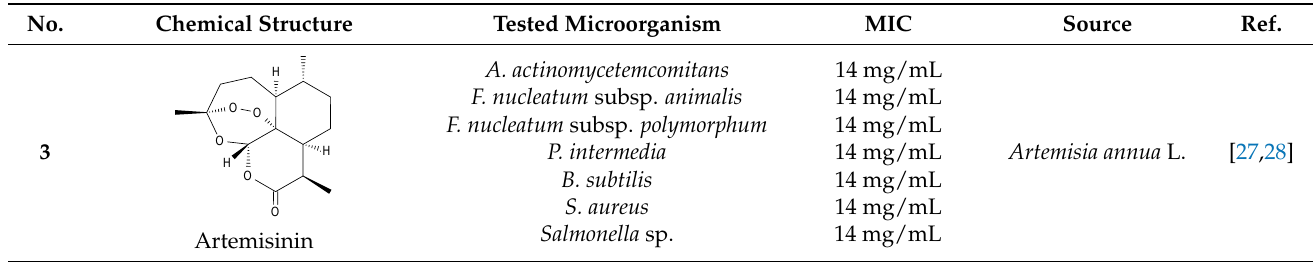
Table 1. Antimicrobial activity of lactones isolated from plants.